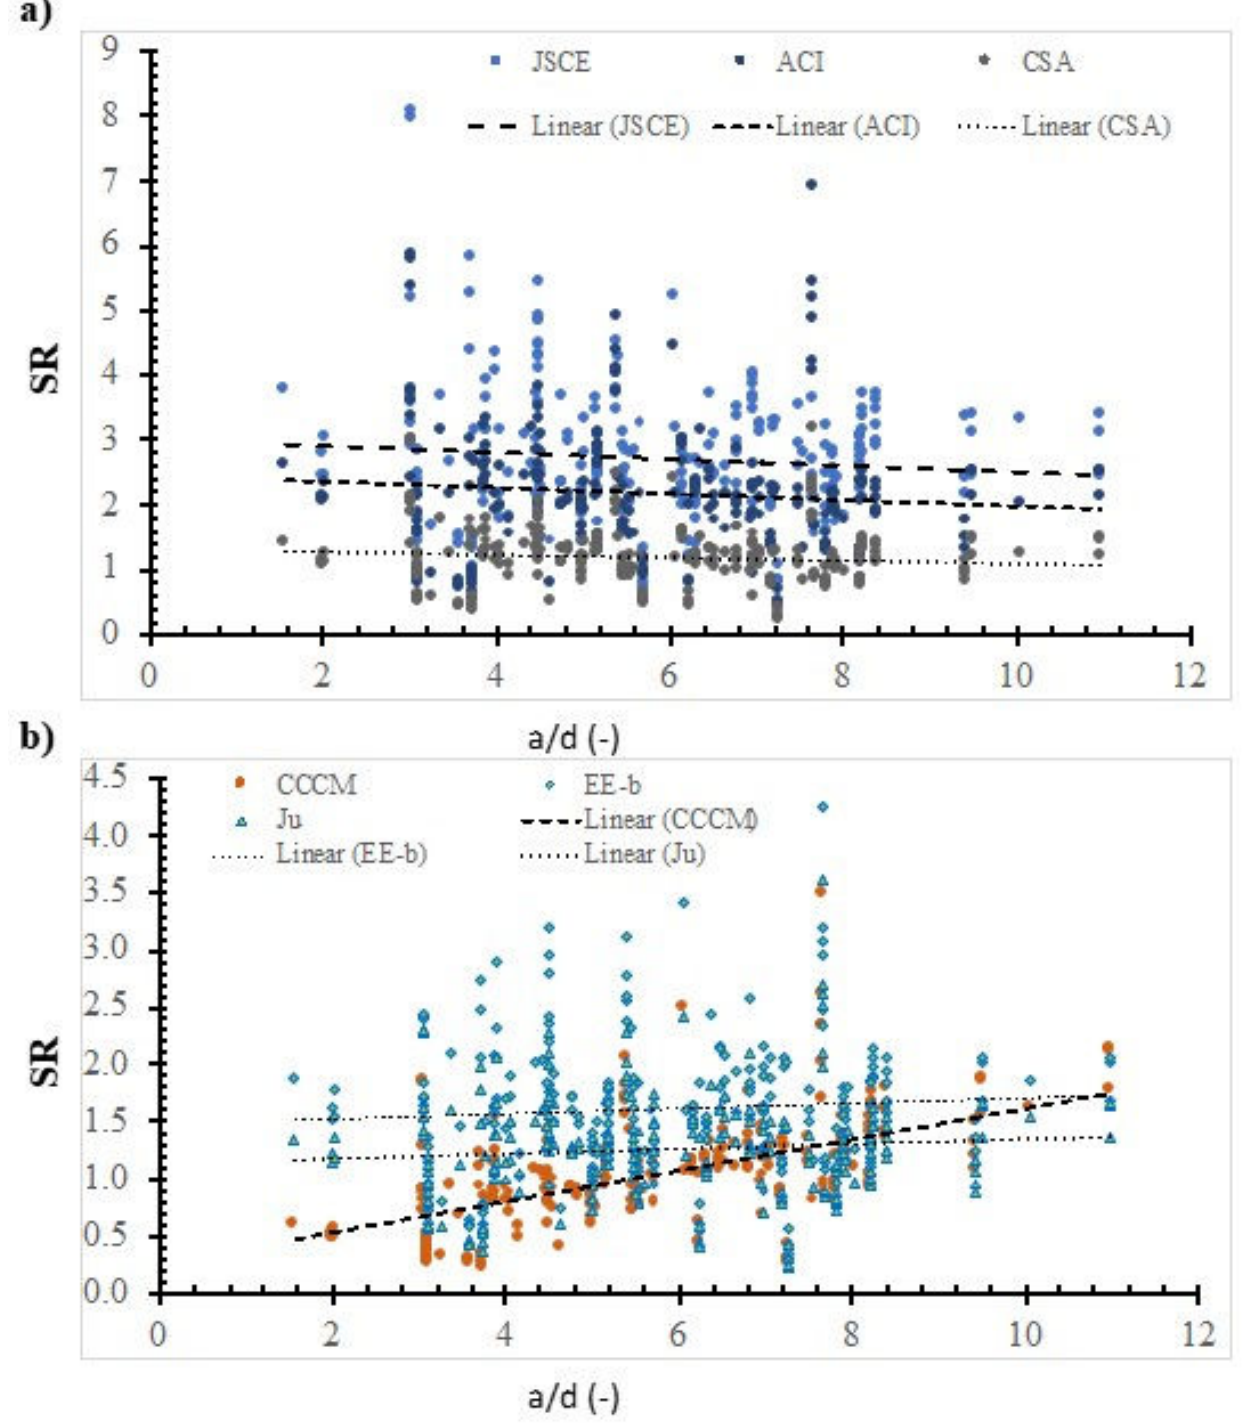
Figure 11. The effect of the shear span-to-depth ratio on the SR value, calculated using selected models. ( a ) Design codes; ( b )